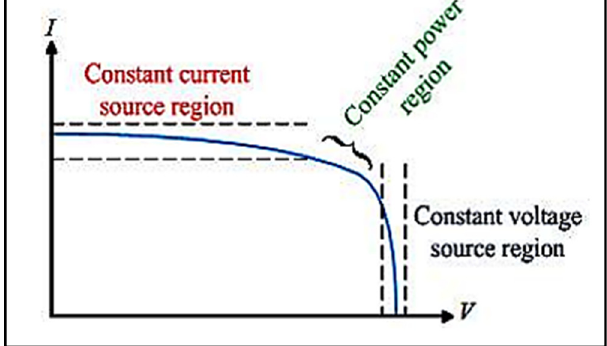
Figure 2. I–V characteristics of PV.